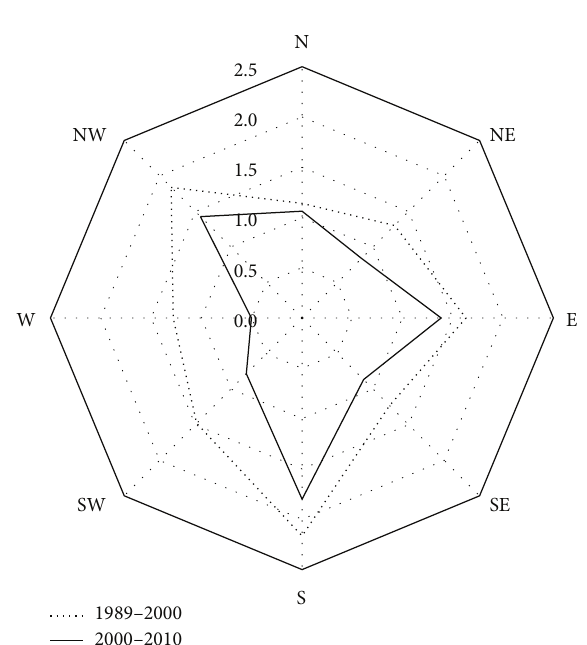
Figure 3: Urban land expanding